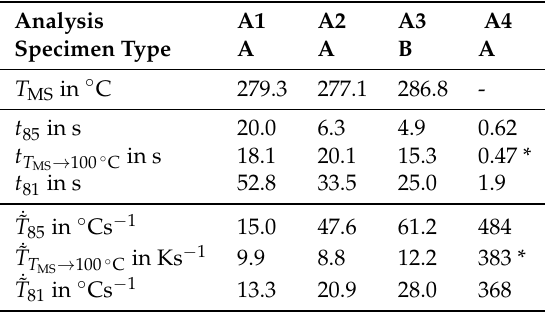
Table 2. Relevant measured quenching parameters and martensite start temperatures of EBSD-analyzed specimens; parameters for A4 refer to measuring point 1 (cid:13)